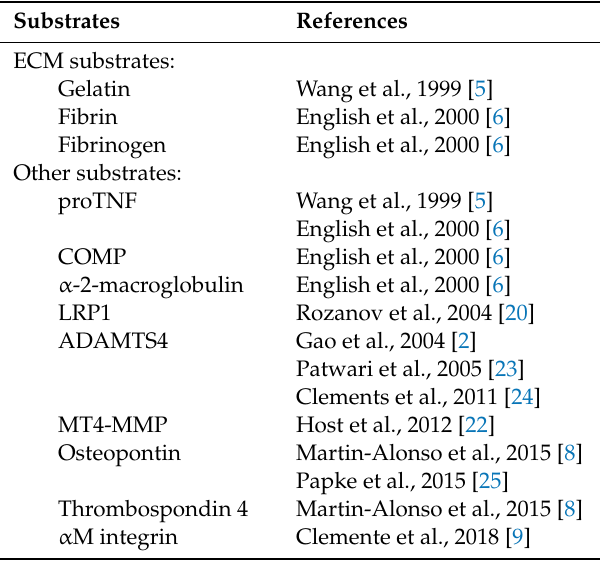
Table 1. Overview of identified substrates of MT4-MMP.